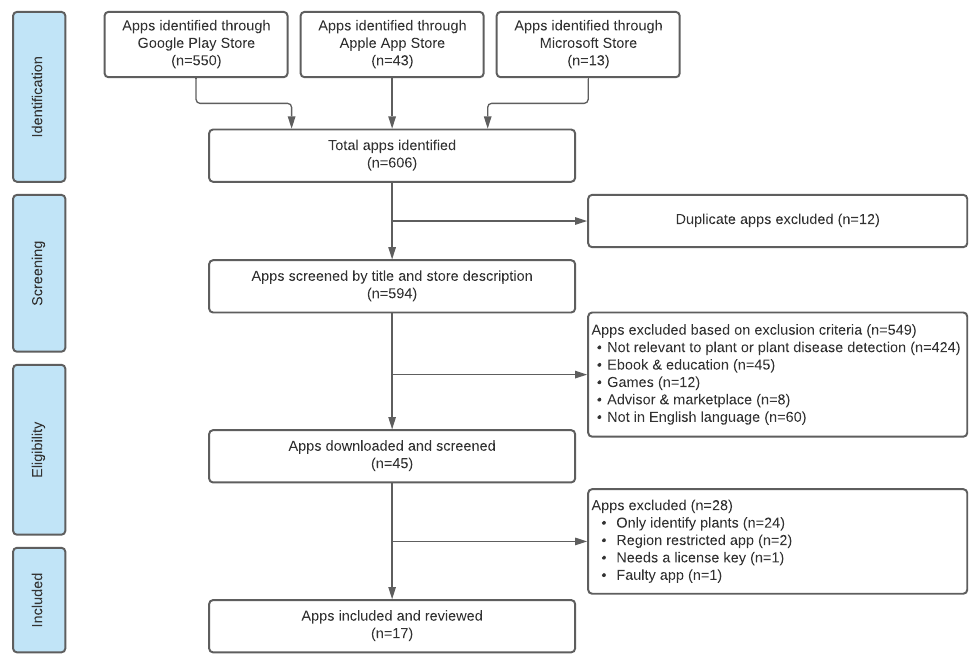
Figure 1. PRISMA diagram of